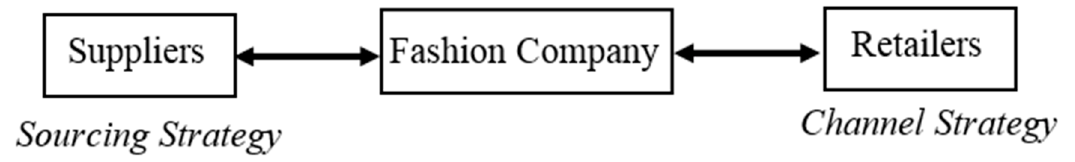
Figure 1. Fashion Supply Chain.